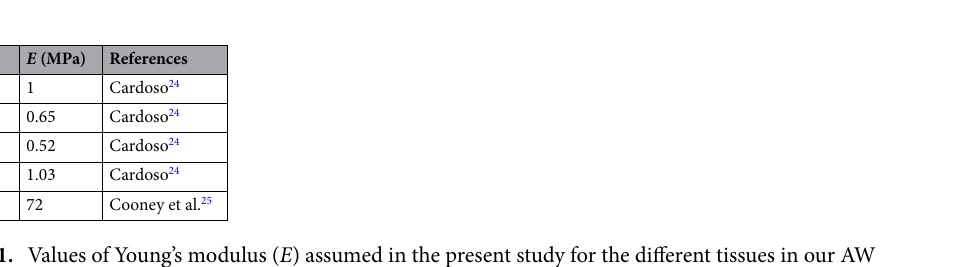
Figure 2. Trephine locations (colored in red) on the outermost AW surface and their labels.